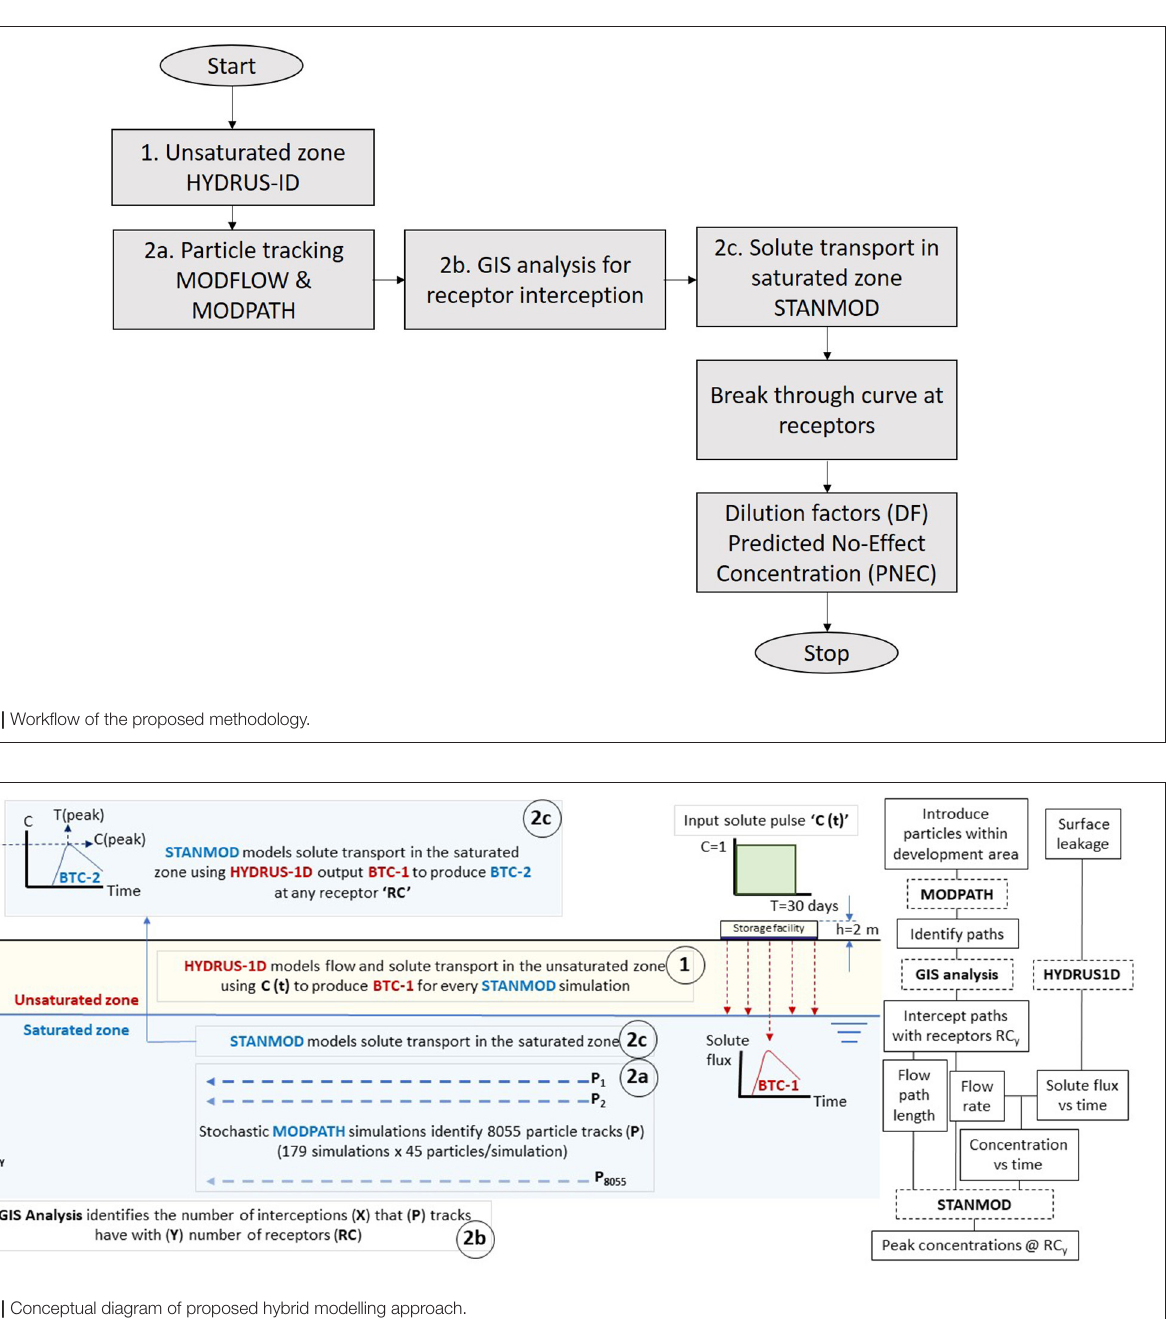
in Figure 2 (encircled “1,” “2a,” “2b,” “2c”), are described in detail